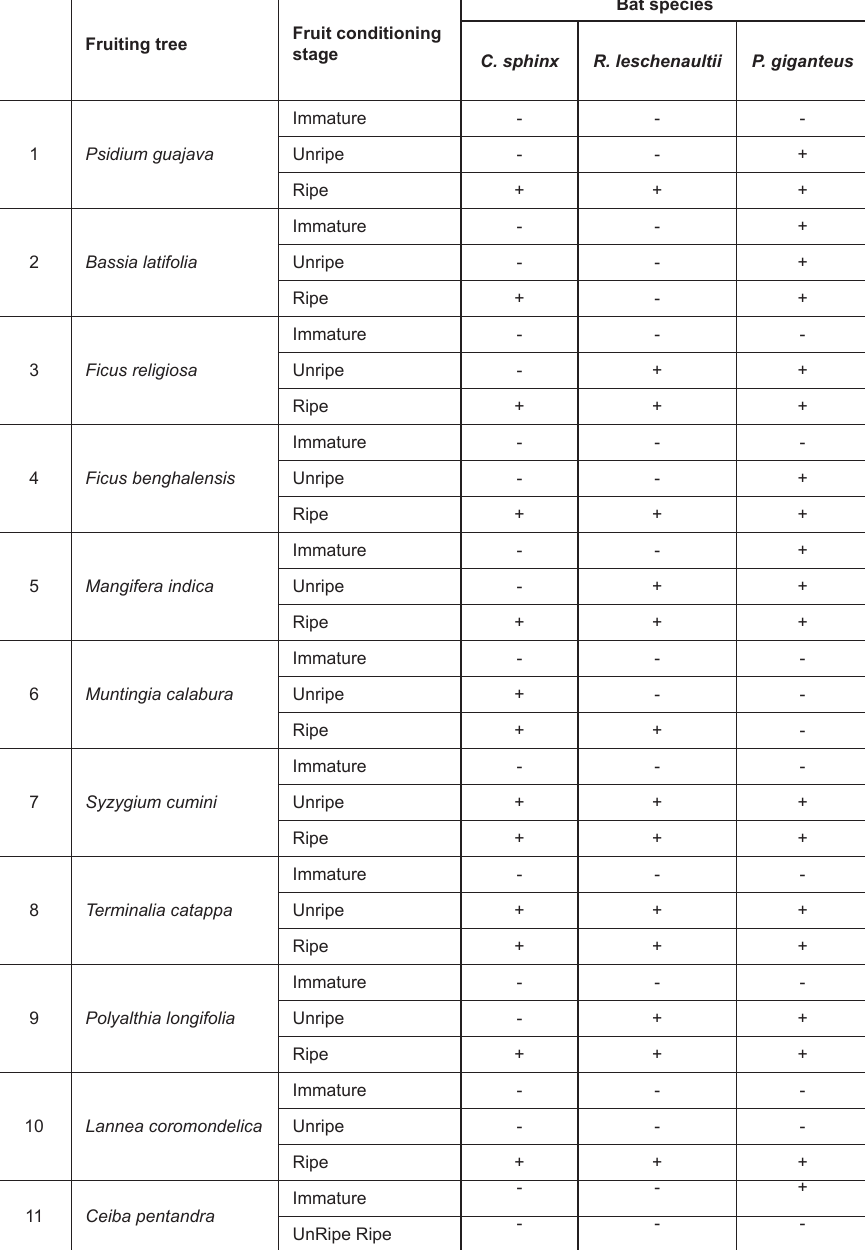
Table 2. Preference of fruits by pteropodid bats on various developmental stages of fruits of various plant